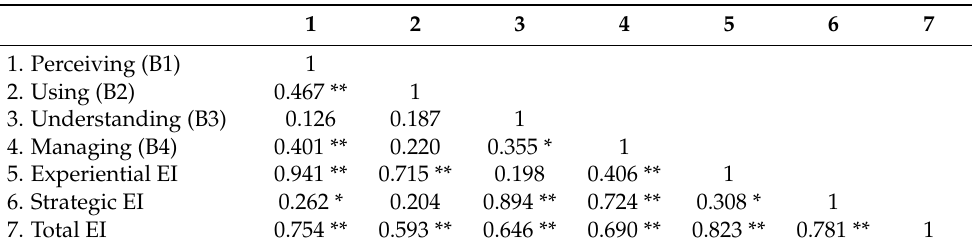
Table 8. Correlations between MSCEIT scores for Study